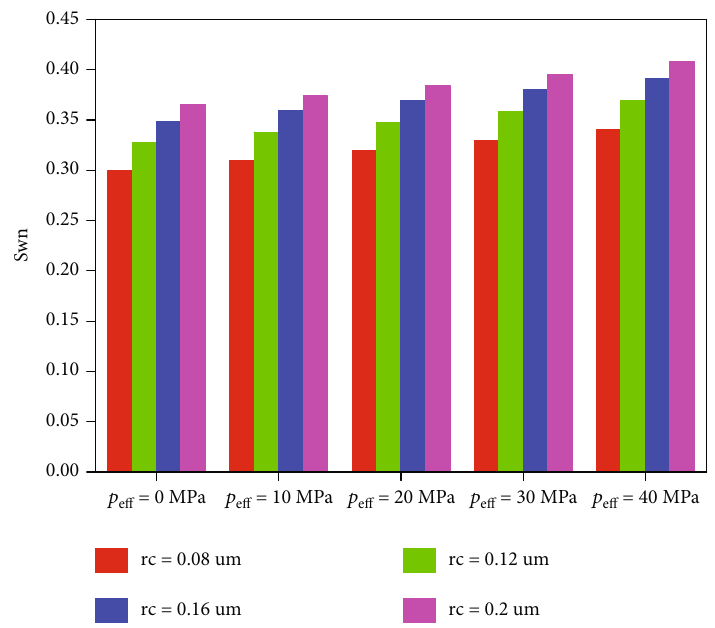
Figure 11: Irreducible water saturation under di ff erent minimum fl ow channel radius.